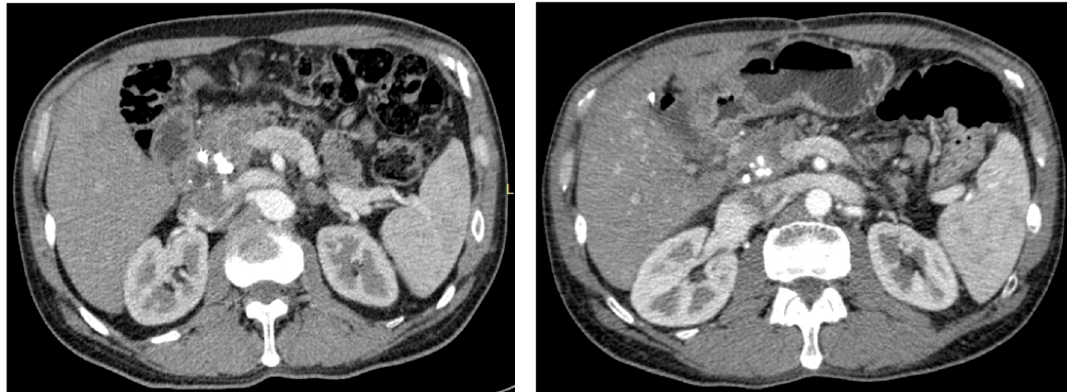
Table 4. Sensitivity, specificity, and accuracy values reported for 25 mm cut-off in reference to the anatomopathological margin infiltration and tumor persistence. AC = Accuracy. SE = Sensitivity. SP = Specificity.